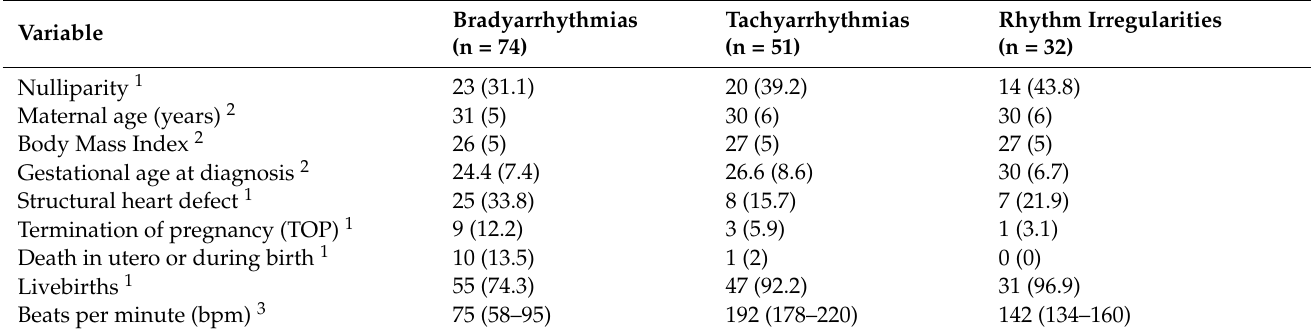
Table 1. Characteristics of the 159 pregnancies with prenatal diagnosis of fetal dysrhythmia.